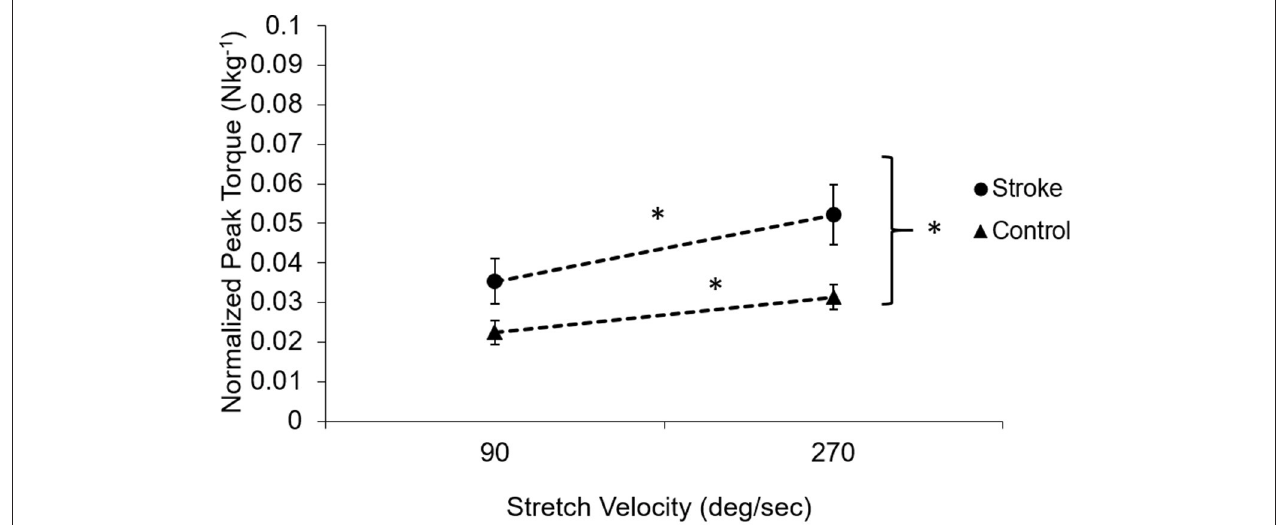
FIGURE 5 | Velocity-dependent property of the muscle in subjects post-stroke (solid circles) and healthy controls (solid triangles). The dotted lines demonstrate the dependence on the velocity. Subjects post-stroke had a stronger velocity dependence compared to healthy controls ( p = 0.02) and had higher torque at all velocities than healthy controls ( p < 0.001). Asterisks (*) indicates significant differences between two velocities.